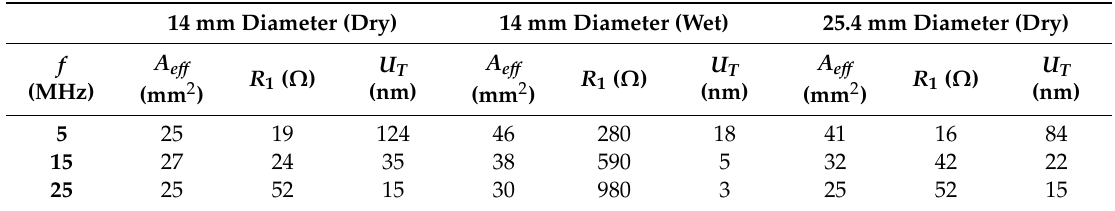
Table A1. Parameters (determined by impedance analysis undertaken with the network analyzer E5100 from Agilent) entering the estimation of the transverse amplitudes and resulting transverse amplitudes in Table